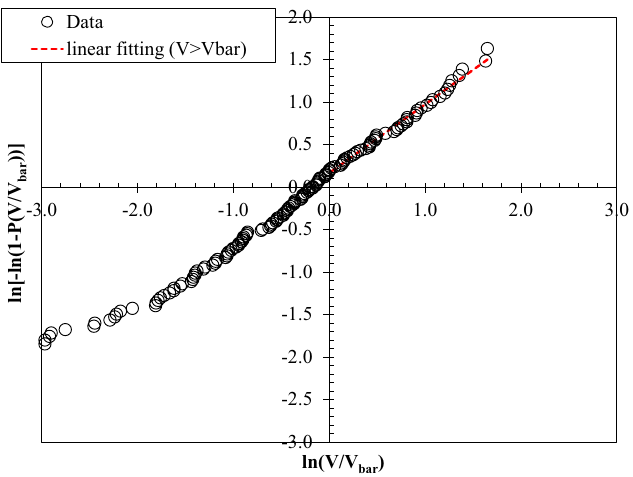
Figure 3. Weibull plot of overtopping volumes for an experiment representing a typical storm wave condition, s op = 5% with a significant wave height of 0.08